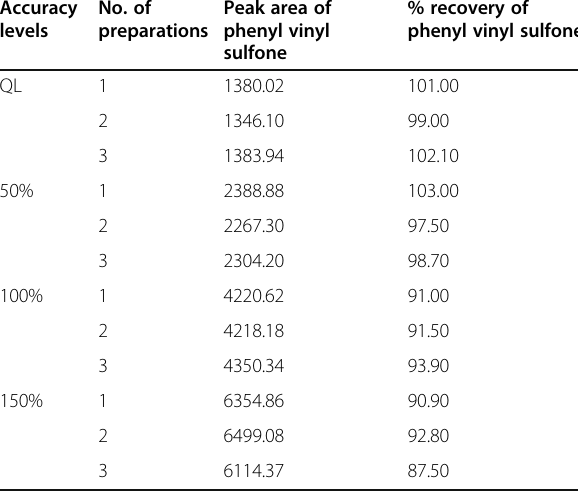
Table 4 Accuracy results of phenyl vinyl sulfone Accuracy levels